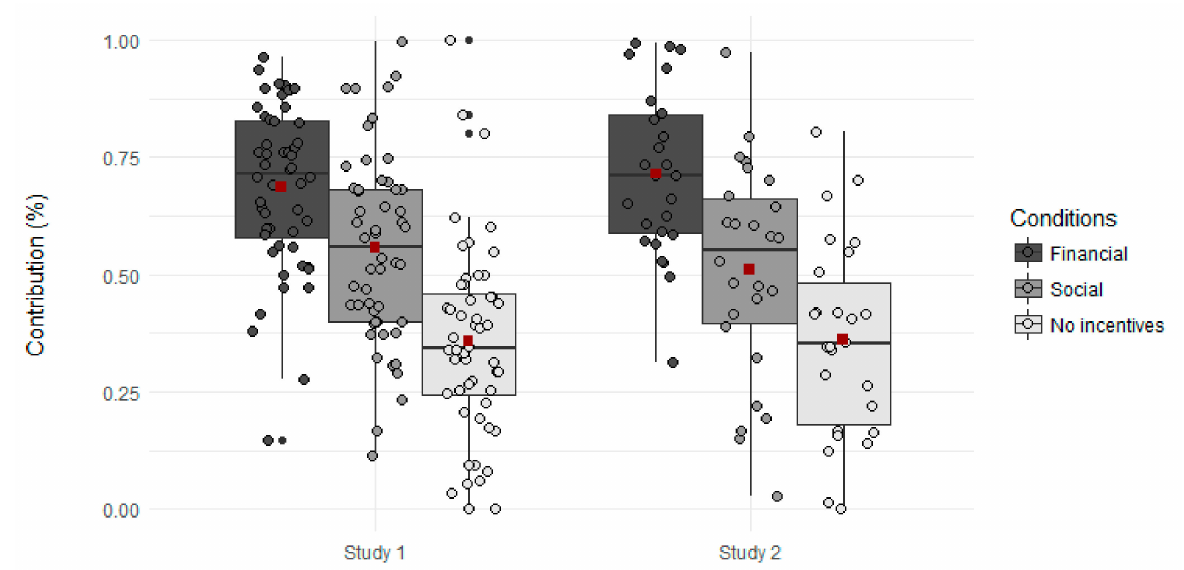
Figure 3. Effect of incentive condition on contributions to the group pot in Study 1 and Study 2. Contributions rates were significantly higher in the incentivized conditions than in the no incentive condition, with contributions being highest in the financial condition. Medians are represented by the middle line within the box-plots, whereas the red squares display means per condition. Individual data points are shown per